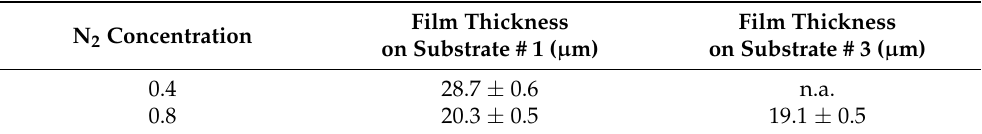
Table 1. Thickness values (with corresponding values of standard deviation) of AlN films deposited on substrate # 1 and # 3 obtained by profilometer measurements. The films were deposited with magnetron sputtering at 0.3 Pa operative pressure and 150 W power value and nitrogen concentration set at 0.4 and 0.8,